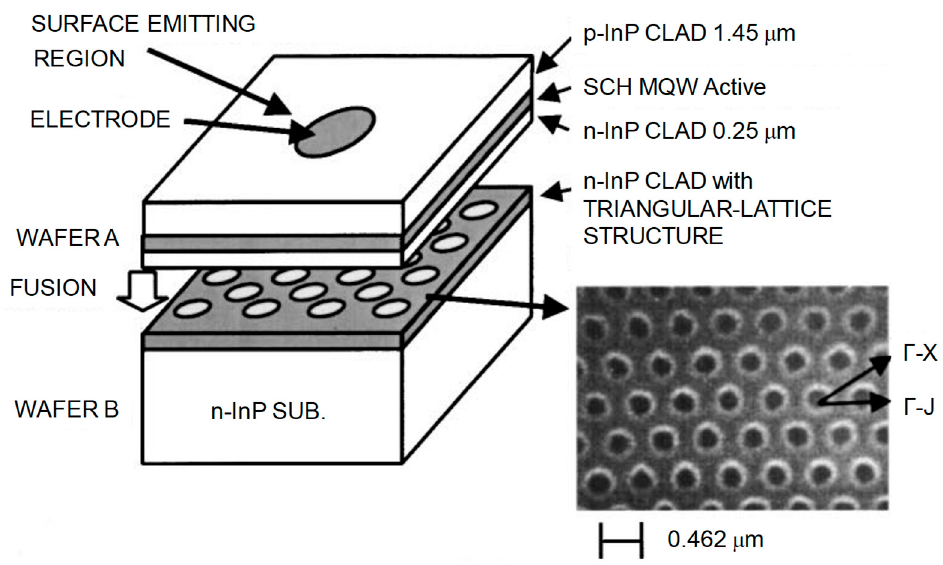
Figure 1. Schematic of the photonic-crystal lasers with triangular-lattice photonic crystal fabricated by wafer-bonding method. The inset shows an SEM image of the fabricated photonic crystal, whose lattice constants is 462 nm. Reprinted from [1], with the permission of AIP Publishing.